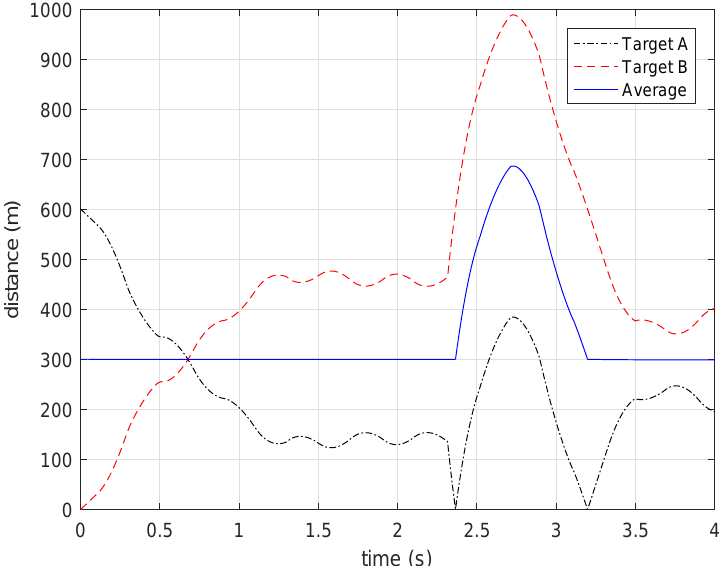
Figure 24. The miss distance, defined as the distance between the tracking point at the target range and its actual location, for targets A and B , as well as their average during a sinusoidal amplitude modulated blink jamming